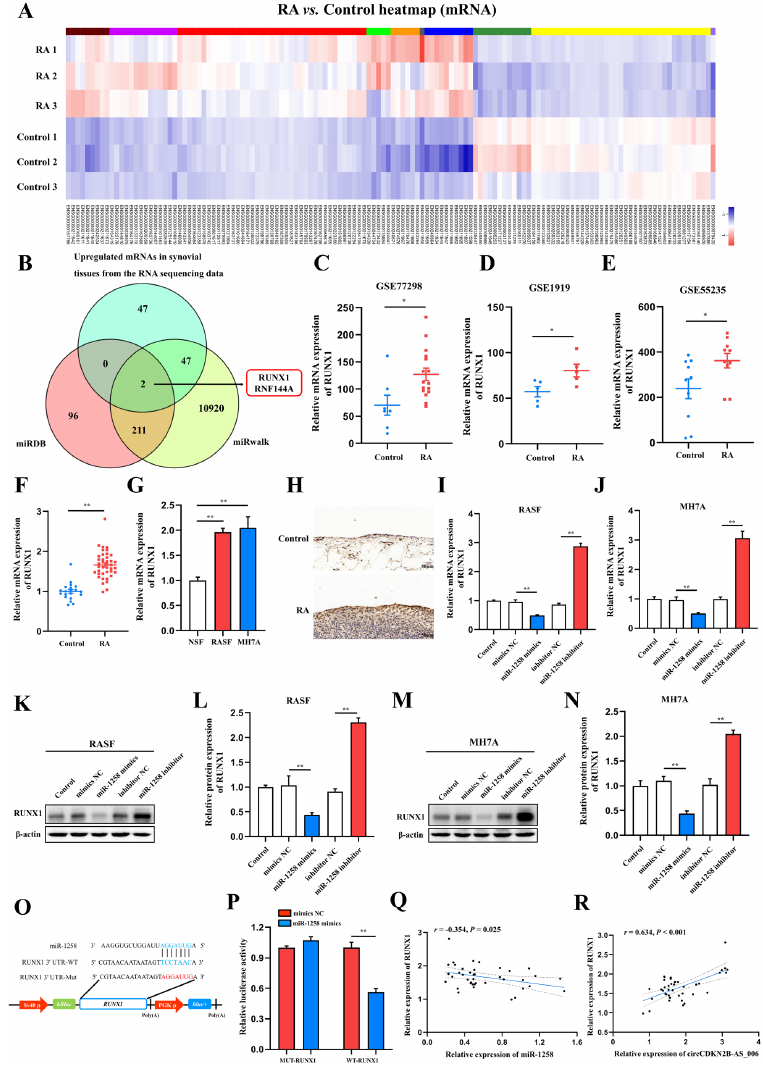
Figure 5. RUNX1 is a direct target of miR−1258. ( A ) Expression heatmap of differentially expressed mRNAs in two groups. ( B ) Venn diagram of the numbers of overlapping targeted mRNAs of miR−1258 predicted by means of two algorithms (miRDB and miRWalk) and the results of whole−transcriptome sequencing (upregulated mRNAs). ( C – E ) RUNX1 expression was significantly downregulated in the synovia from RA patients according to the NCBI GEO database (GSE77298, GSE1919, and GSE55235). ( F ) The relative expression of RUNX1 was detected in the synovia from RA patients ( n = 40) and non-RA patients ( n = 16) by means of RT − qPCR. ( G ) RT − qPCR analysis of the relative expression levels of RUNX1 in RASFs, MH7A cells, and NSFs. ( H ) Immunohistochemistry staining showing the protein expression of RUNX1 in the synovia from RA patients and non − RA patients. ( I , J ) The mRNA expression of RUNX1 in RASFs and MH7A cells transfected with miR − 1258 mimics or inhibitors. ( K – N ) The protein expression of RUNX1 in RASFs and MH7A cells transfected with miR − 1258 mimics or inhibitors. ( O ) Schematic of the RUNX1 3 (cid:48) UTR wild − type (WT) and mutant (MUT) luciferase reporter vectors. ( P ) Dual − luciferase reporter assays were carried out to detect the relative luciferase activity of luciferase reporter plasmid containing the RUNX1 3 (cid:48) UTR wild − type (WT) or mutant (MUT), which were cotransfected with the miR − 1258 mimics or NC mimics. ( Q ) Correlation analysis between miR − 1258 and RUNX1 expression in the synovia from RA patients. ( R ) Correlation analysis between circCDKN2B − AS_006 and RUNX1 expression in the synovia from RA patients. ** p < 0.01, * p <